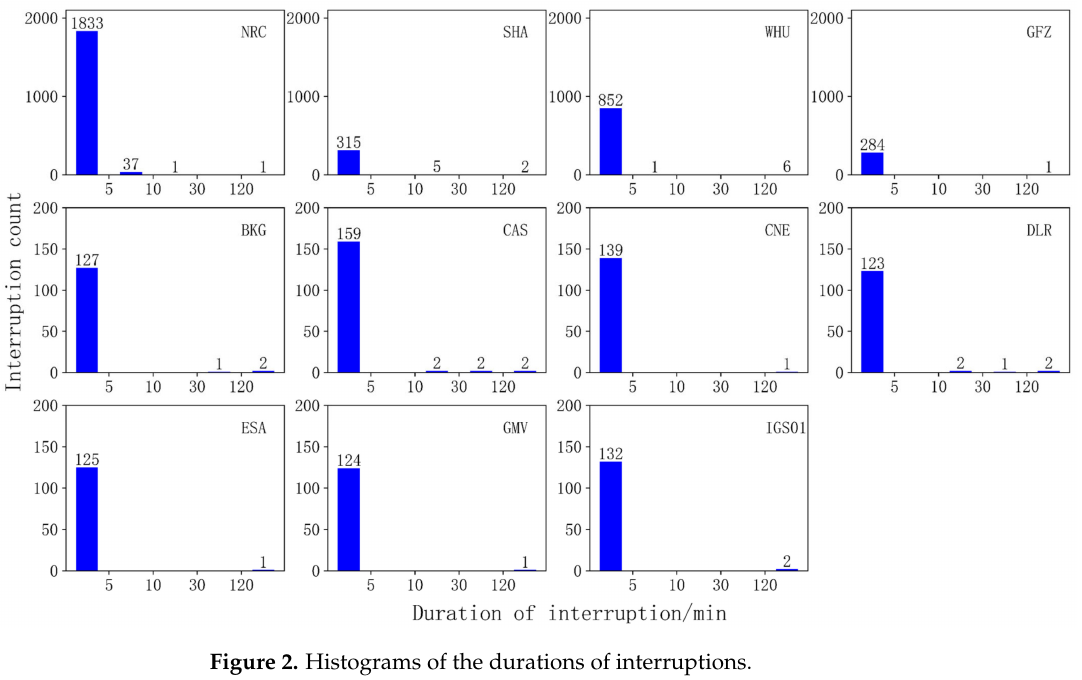
Figure 2. Histograms of the durations of interruptions.